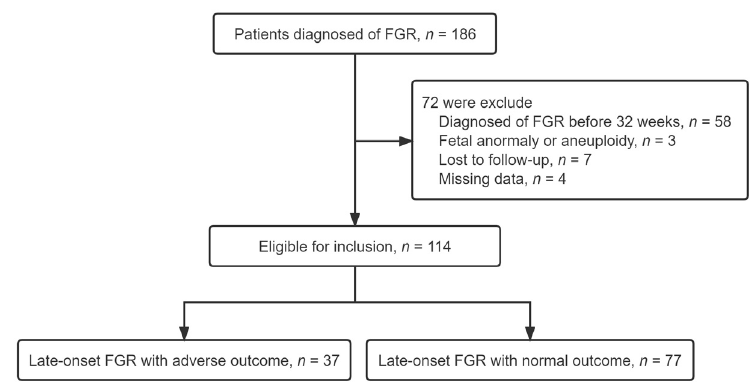
Figure 1. Process of pregnant patient inclusion beginning from the initial search to final inclusion. A total of 186 participants were excluded from the analyses because they were subsequently lost to follow-up, missing data, diagnosed with early-FGR, congenital malformations or aneuploidy. There were 114 eligible women enrolled. Thirty-seven pregnant women with late-onset FGR had adverse perinatal outcomes and were assigned to the study group; the remaining 77 pregnant women with late-onset FGR had normal perinatal outcomes and were assigned to the control group.